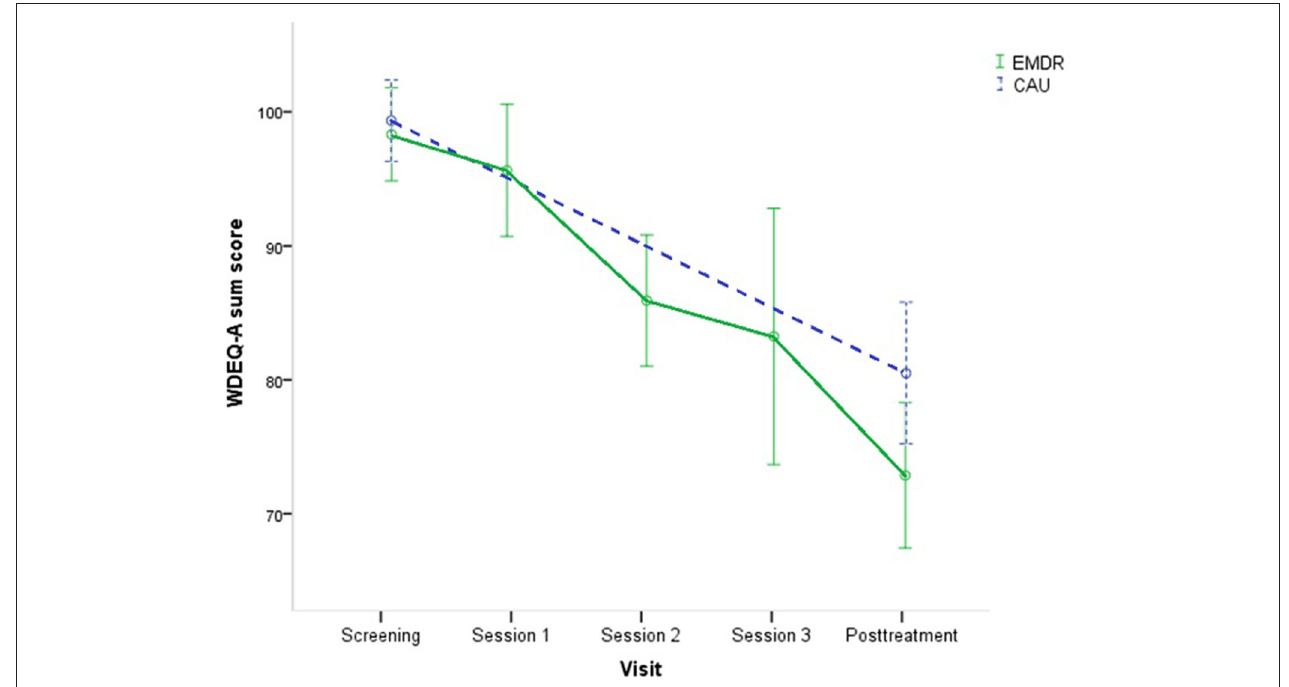
FIGURE 2 | Mean WDEQ-A scores with 95% C.I. at each time point, for EMDR therapy group ( n = 58) and CAU ( n = 52) condition. CAU, Care-as-Usual; EMDR; Eye Movement Desensitization and Reprocessing therapy; WDEQ-A, Wijma Delivery Expectancy Questionnaire—version A.